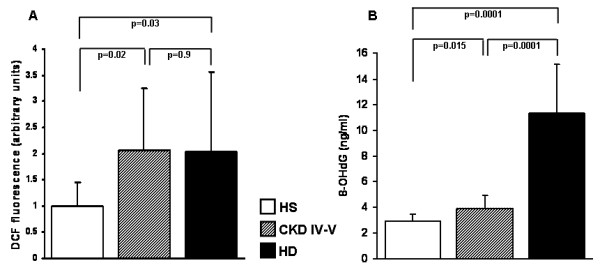
Intracellular reactive oxygen species (ROS) and serum 8-hydroxydeoxyguanosine (8-OHdG) levels in healthy subjects (HS), chronic kidney disease (CKD IV–V) and hemodialysis (HD) patients. The histograms represent the mean ± SD of 2',7'-Dichlorodihydrofluorescein (DCF) fluorescence (A) and serum 8-OHdG levels (B) in 12 HS, 10 CKD and 14 HD patients. DCF fluorescence in PBMC, reflecting the relative ROS levels, and the serum 8-OHdG levels were higher in HD and CKD compared to HS. In addition HD patients had higher 8-OHdG levels compared to CKD.